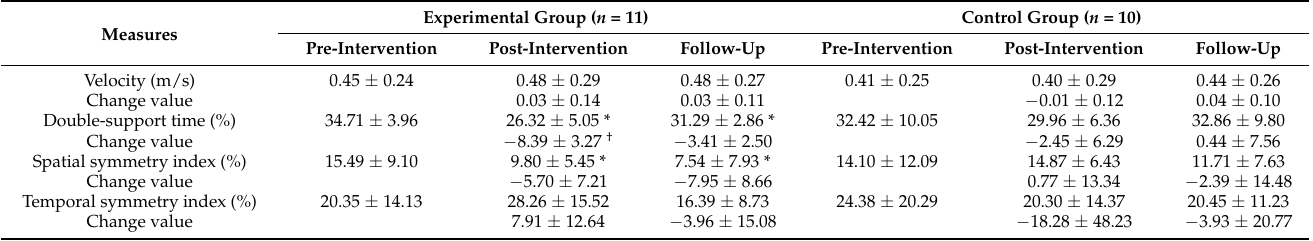
Table 2. Comparisons of gait performance.